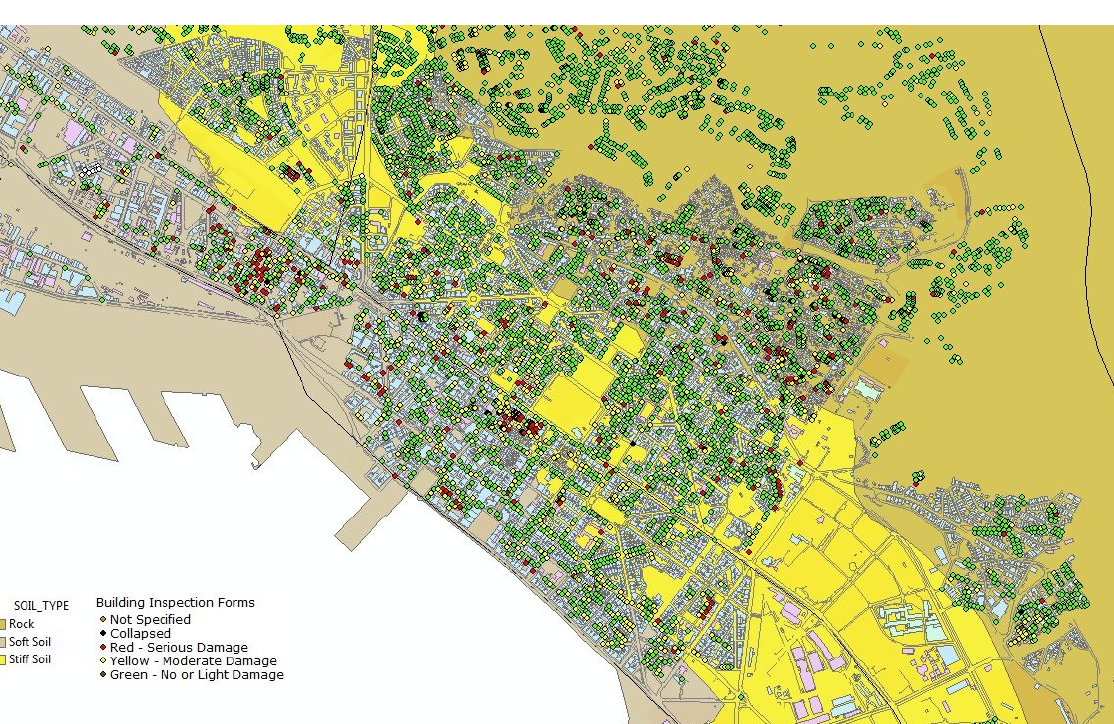
Figure 7. Classification of the structural condition of the buildings at downtown Thessaloniki following the 1978 earthquake with the help of the Synarma system tools: Green dots represent buildings with light or no damage; yellow dots show buildings with moderate damage, while red dots indicate serious structural damage. Black dots show collapsed buildings. Most damage was observed in areas with soft soil and old structures, while heavy structural damage was observed also in the upper part of the city concerning old buildings despite the rock soil